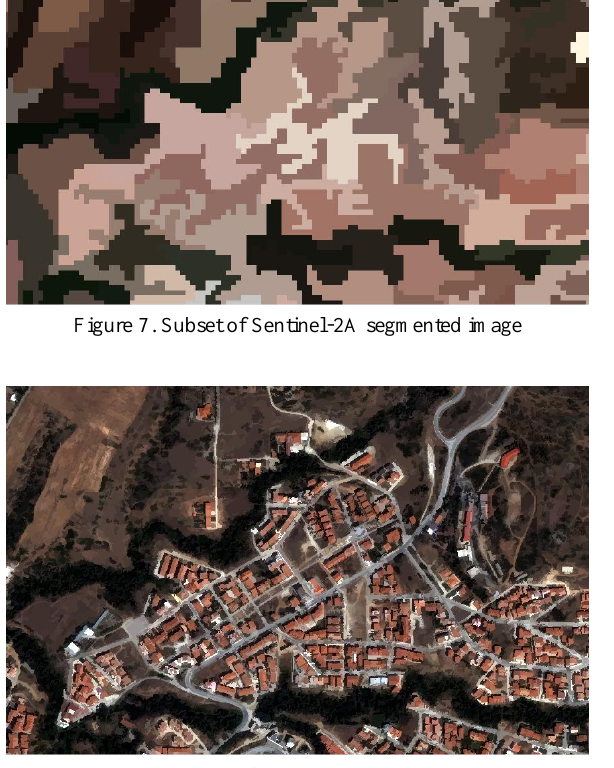
Figure 8. Subset of Quickbird segmented